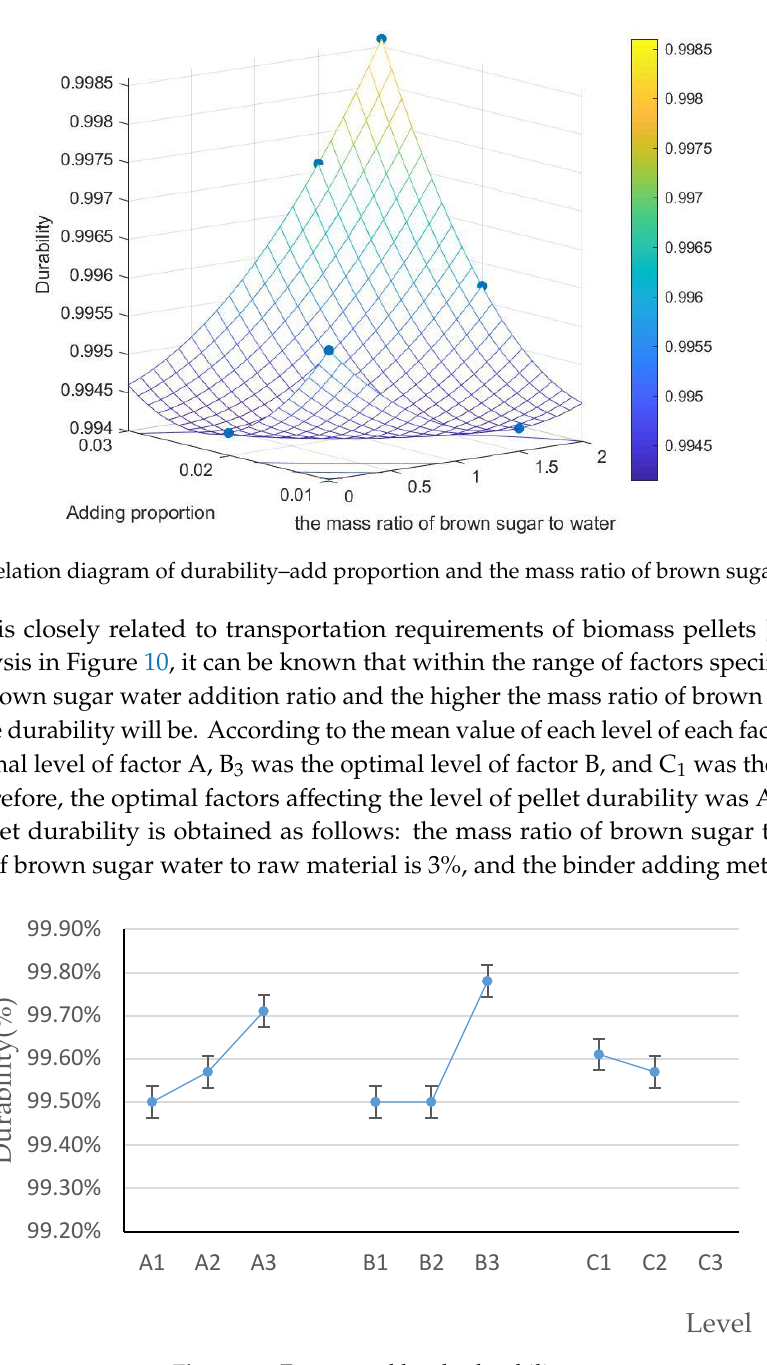
Figure 11. Factors and levels–durability.